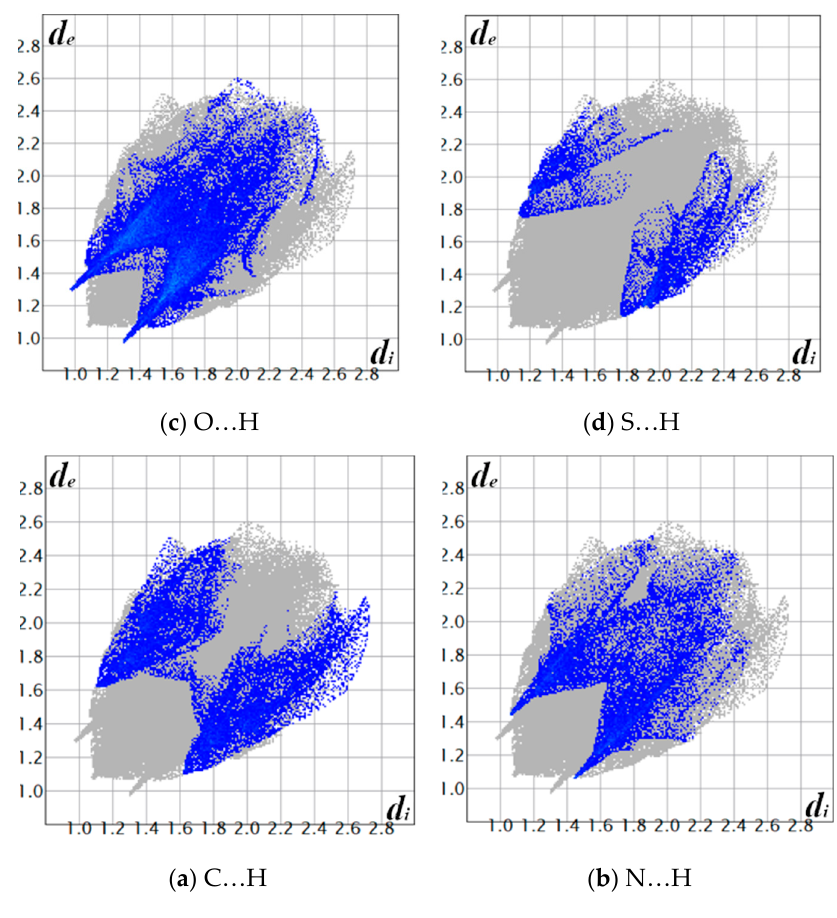
Figure 6. The Hirshfeld surface for 4 . The d norm is viewed from the c-axis.